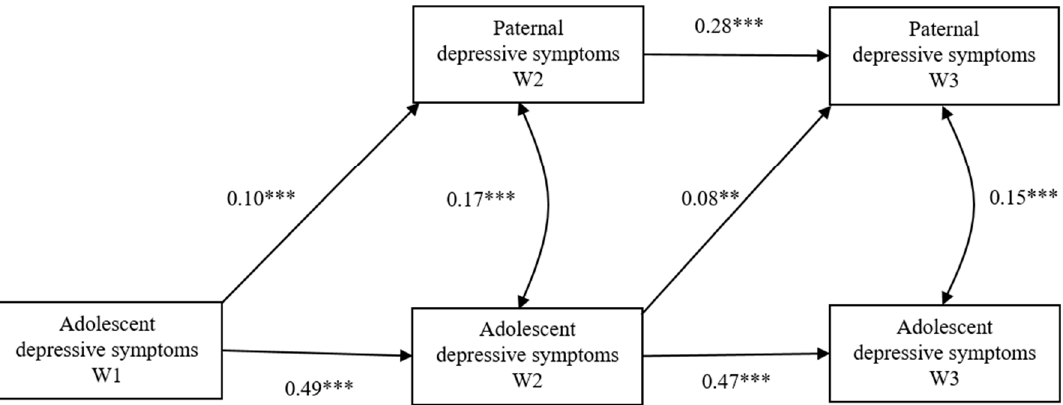
Figure 2. The cross-lagged model between paternal depressive symptoms and adolescent depressive symptoms. ** p < 0.01, *** p < 0.001.